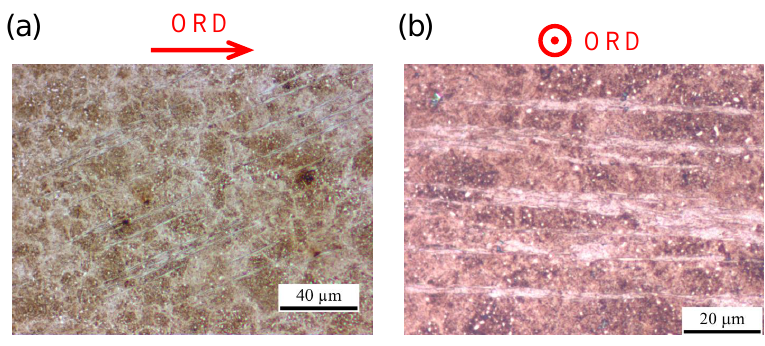
Figure 1. Formation of WEBs in a bearing inner ring observed from the circumferential section ( a ) and the axial section ( b